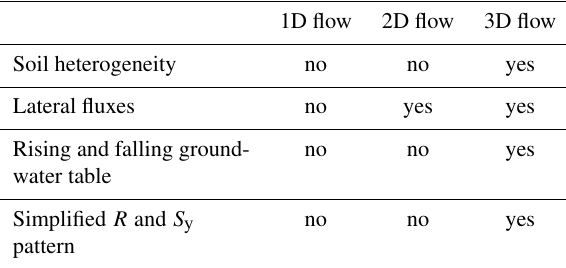
Table 1. Main features of the three test